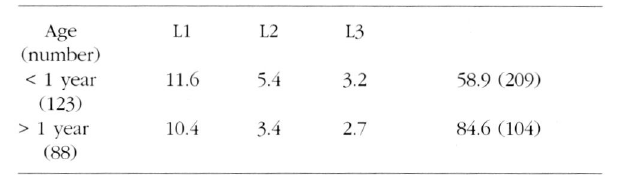
Table I. - Oestrus oris in Algerian sheep: intensity of the three ins- tars and prevalence.